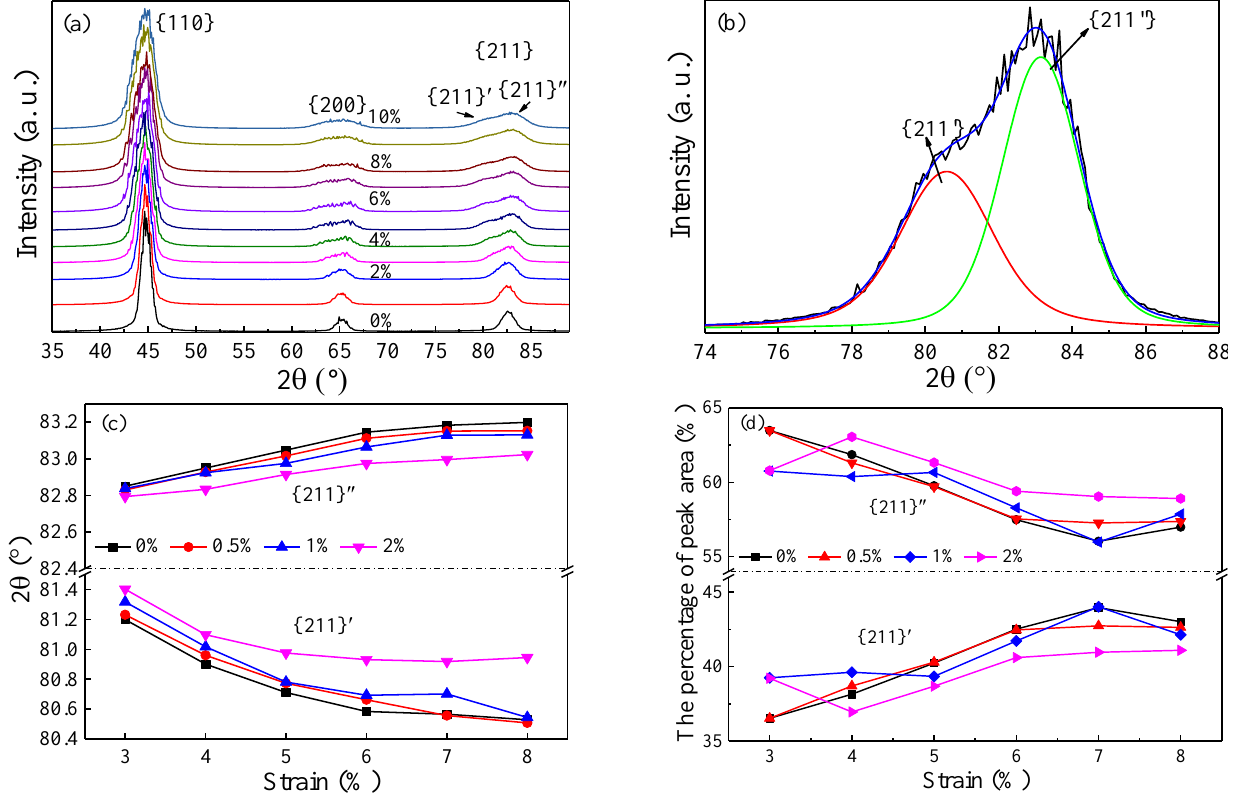
Figure 6. ( a ) The simulated XRD patterns of the nanocrystalline Fe in a strain interval of 0–10%; ( b ) the {211} peak and the fitting result by two peaks for the nanocrystalline pure Fe deformed to 6% ; ( c ) the peak position of {211}′ and {211}″ as a function of strain; and ( d ) the peak area of {211}′ and {211}″ as a function of strain.